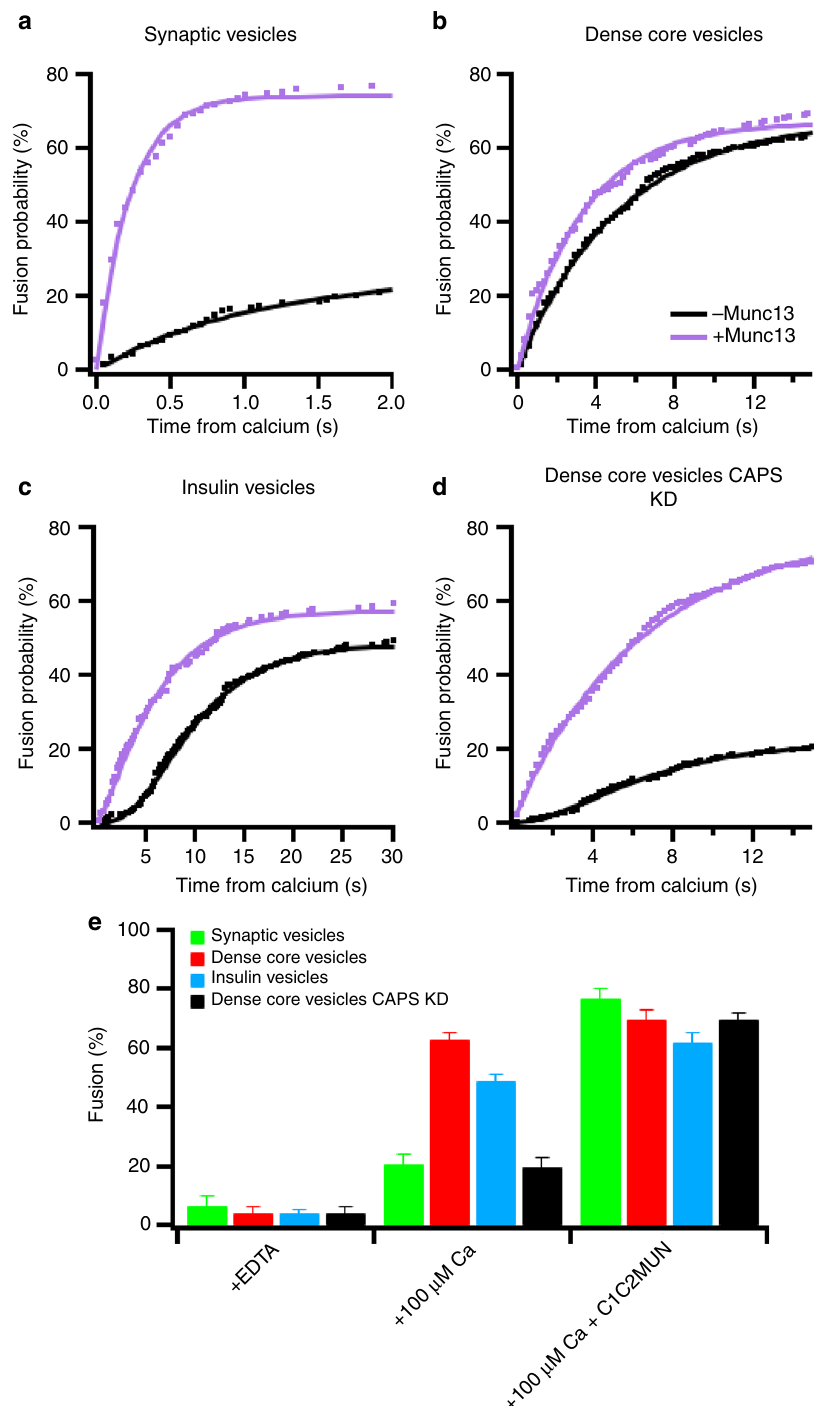
Fig. 4 Munc13 dependence of secretory vesicle kinetics. Cumulative distribution functions for synaptic vesicles ( a ), dense-core vesicles ( b ), insulin vesicles ( c ), dense-core vesicles lacking endogenous CAPS-1/2 (previously described in ref. 3 ) ( d ). All kinetics are triggered from a docked state in the presence of syntaxin-1a:dSNAP-25, Munc18, complexin-1 without (black), or with (purple) 0.2 μ M of the C1C2MUN domain fragment of Munc13. Summary statistics for each condition are shown in Supplementary Table 2. e Bar graph for the total amount of fusion in the presence of 100 µ M EDTA, 100 µ M calcium, or 100 µ M calcium in the presence of 0.2 µ M C1C2MUN domain of Munc13 for each condition. Error bars represent standard errors of the